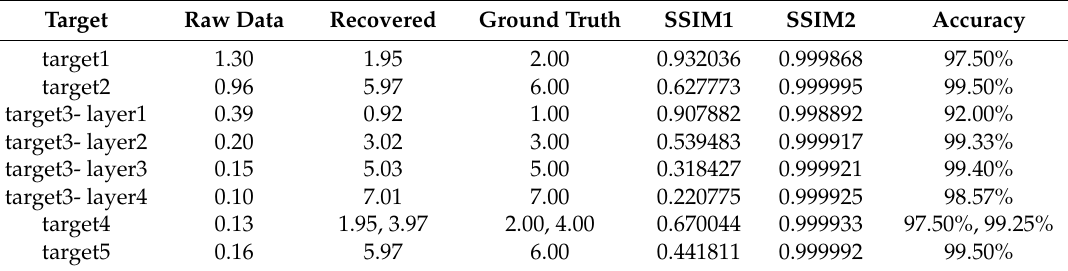
Figure 6. ( a ) Absorption energy distribution before iteration recovery; ( b ) Absorption coefficient distribution after iterative recovery; ( c ) The iteration error. Table 2. Results for quantitative recovery of absorption coefficient.